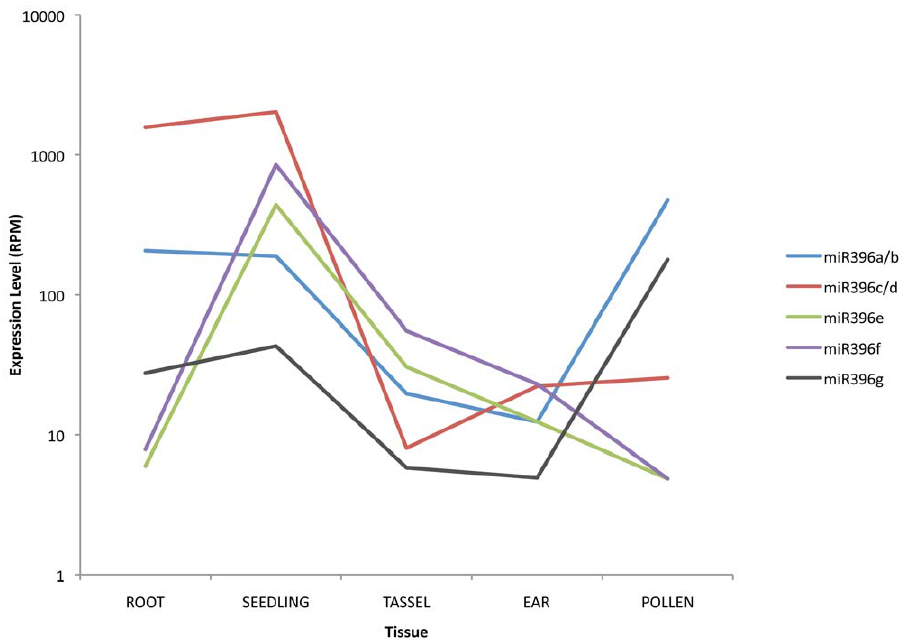
Figure 4. Expression levels of miRNA genes from miR396 family across tissue types. Solexa reads mapping to the miR396 family were counted and summed for each family member, showing tissue specificity of expression amongst members of the same family. Read counts are plotted as Reads Per Million (RPM) on a log scale.